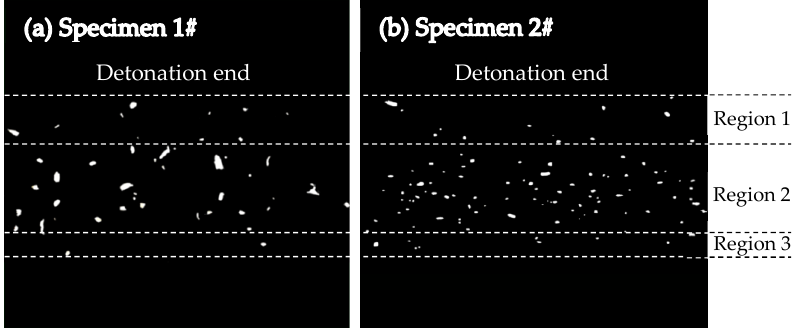
Figure 3. Witness plates showing hole distributions: ( a ) Witness plate showing hole distribution for Specimen 1#; ( b ) Witness plate showing hole distribution for Specimen 2#.